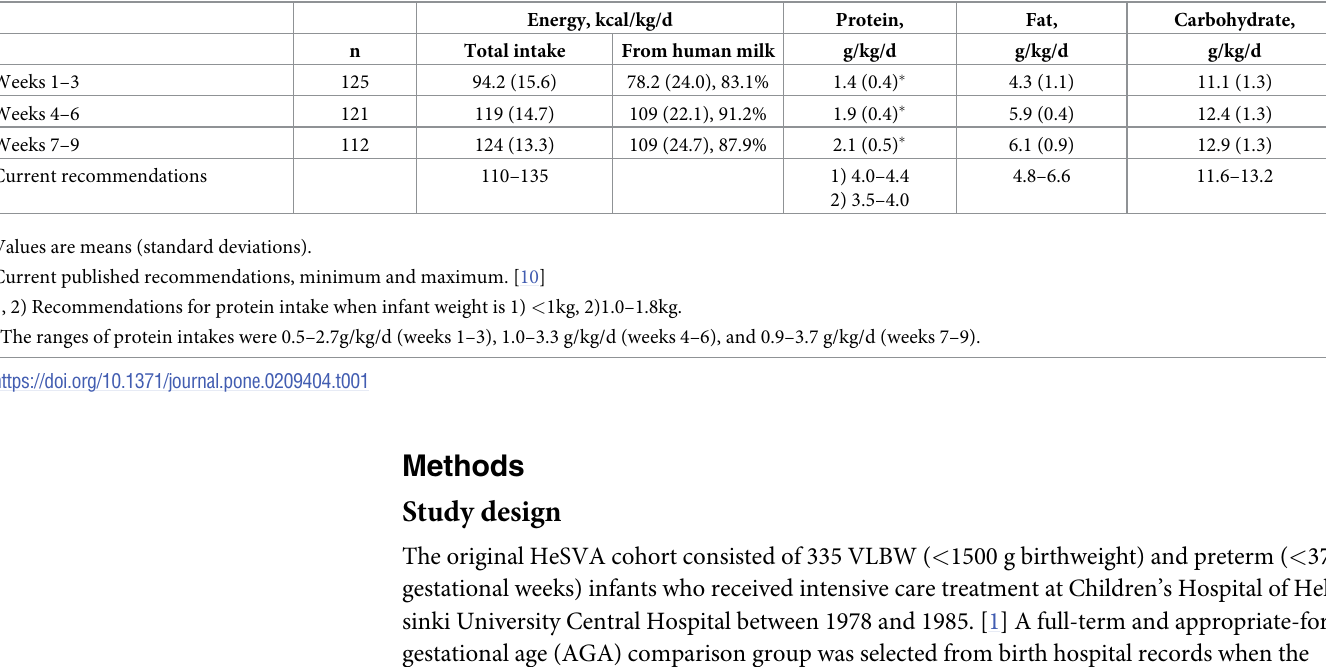
Table 1. Intakes of energy and macronutrients during the first nine weeks of